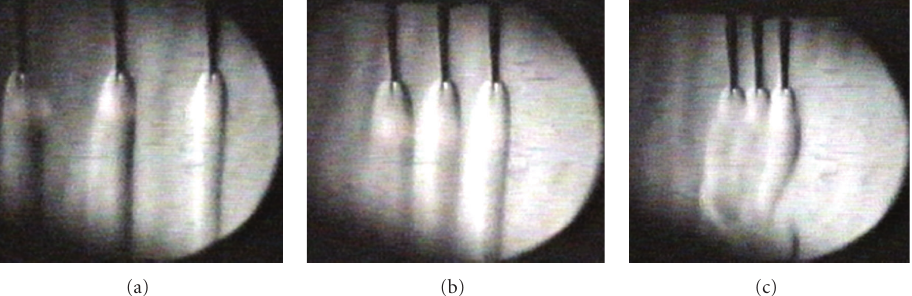
Figure 19: Sequence of Schlieren images for 14.8 mL/min/burner of C 3 H 8 ( Re i = 2 . 97): (a) 64 burner widths (2in), (b) 32 burner widths (1in), and (c) 16 burner widths (0.5in).